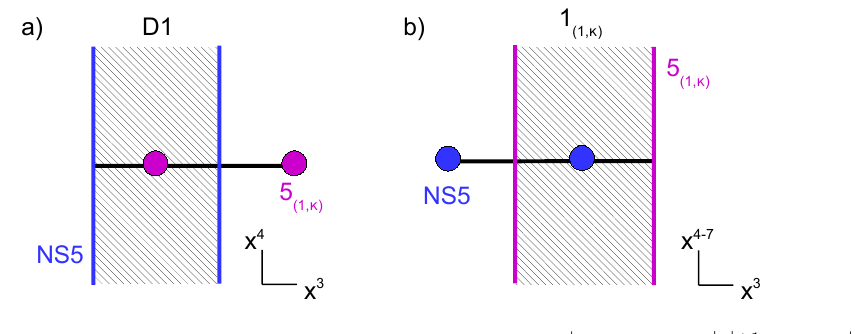
Figure 16 . Brane setups associated to the relations: (a) v + ( X II ) j (cid:20) j +1 .